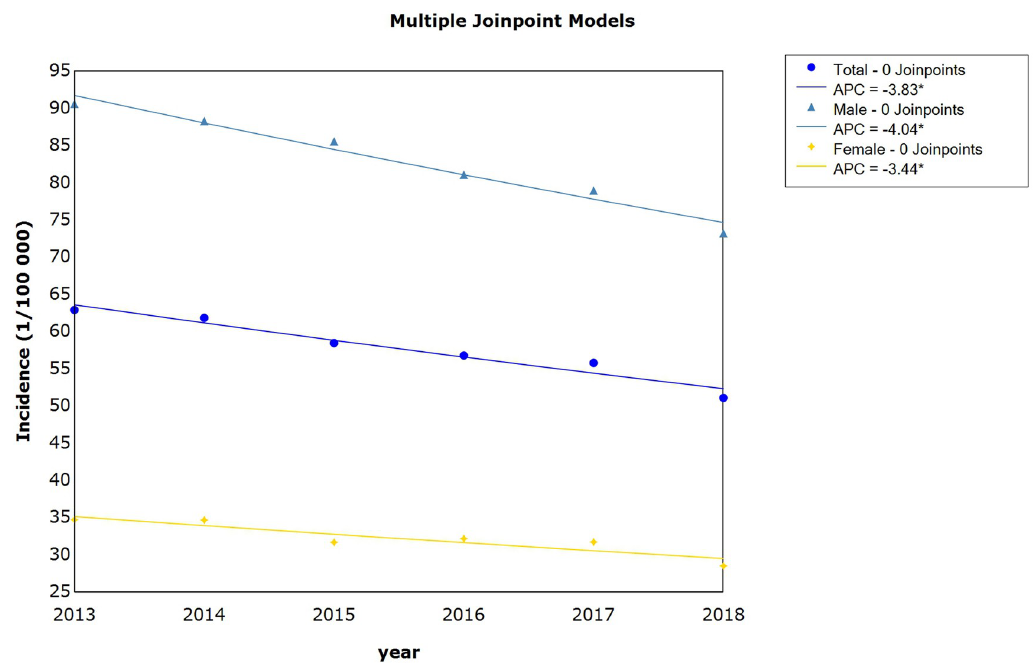
Fig 1. Trends in pulmonary tuberculosis incidence rates by sex in Anhui province, Eastern China from 2013 to 2018, as determined using the join-point regression analysis. APC, average percent change.